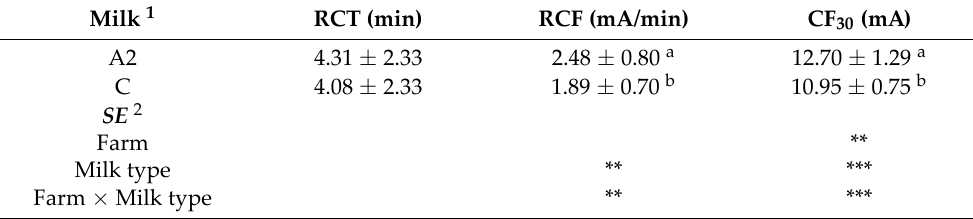
Table 6. Rennet coagulation properties calculated with Optigraph ® of A2 and control